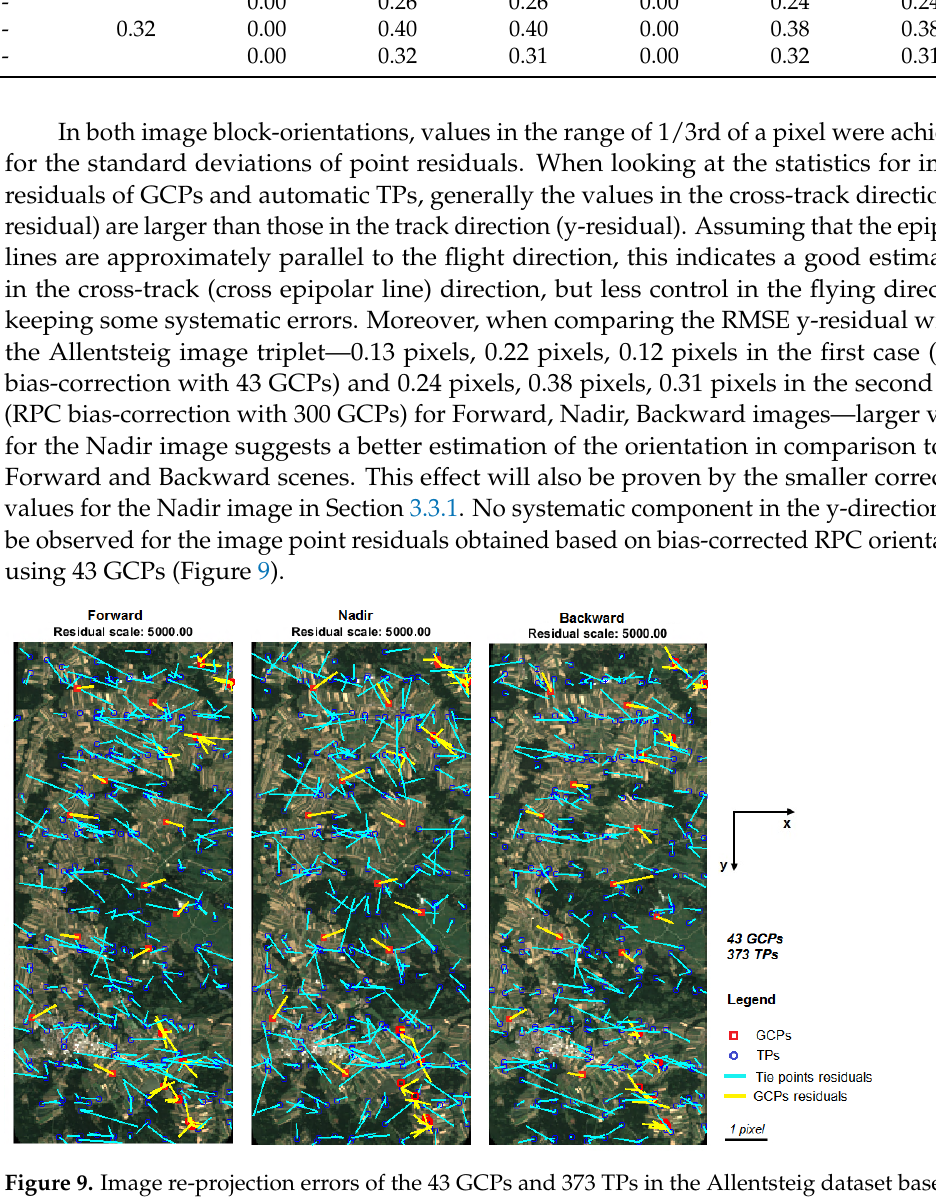
Figure 9. Image re-projection errors of the 43 GCPs and 373 TPs in the Allentsteig dataset based on bias-corrected RPC orientation. Overview of scaled image residuals in Forward, Nadir and Backward images. The vectors were exaggerated 5000 times to enable better